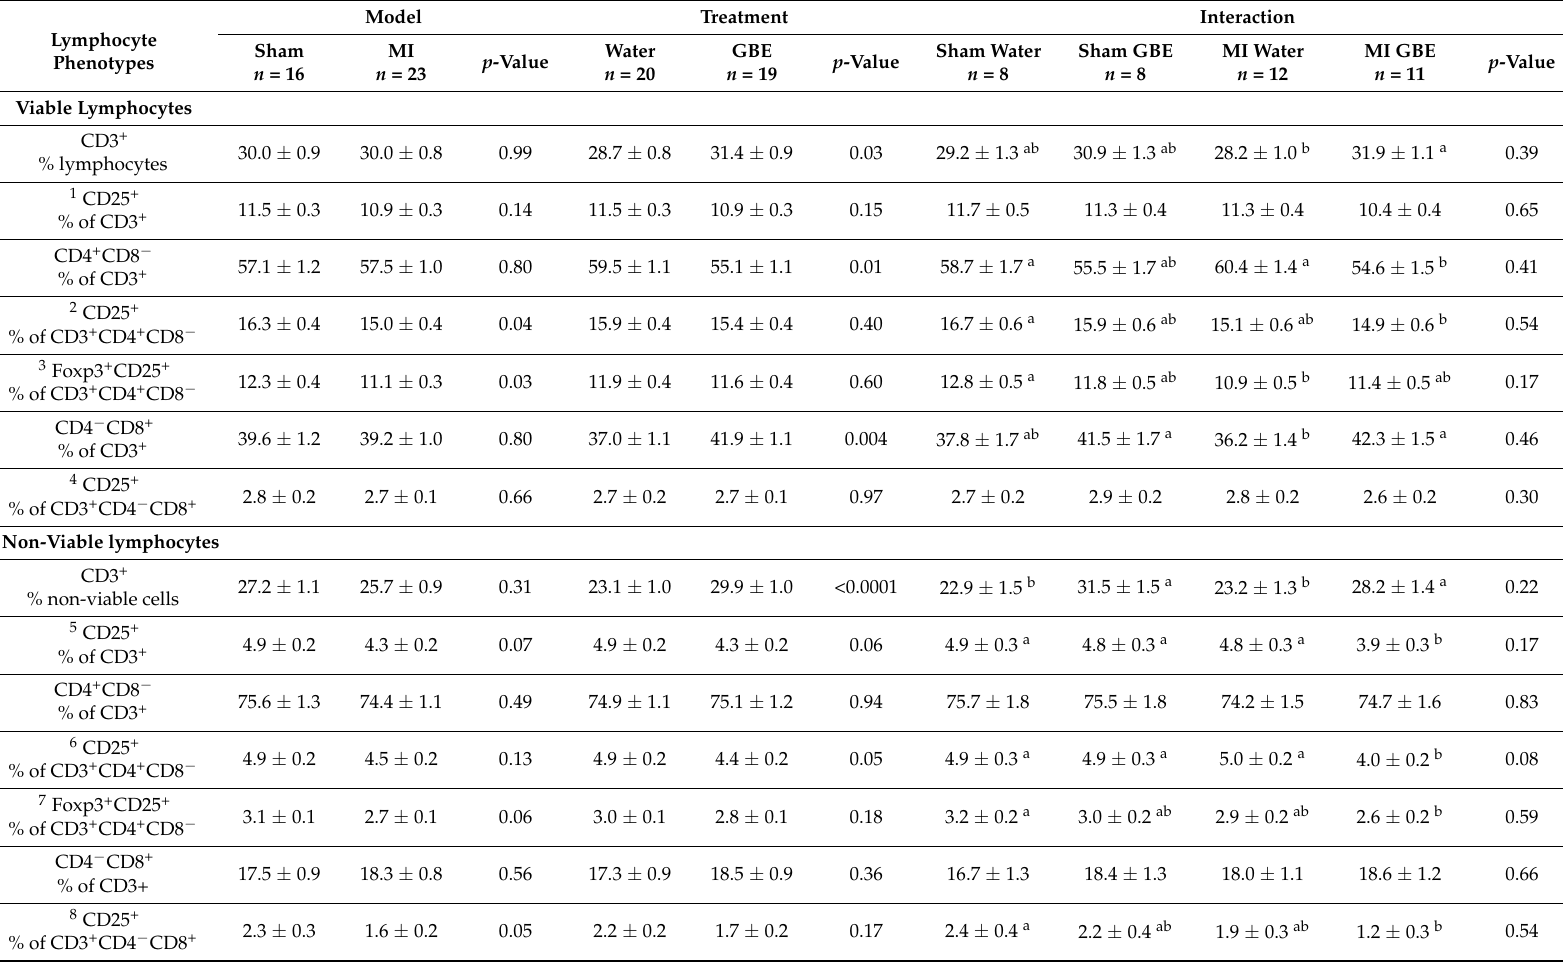
Values are means (pg/mL) ± standard error. Means with different superscript letters are significantly different ( p < 0.05). GBE: Ginseng berry extract. 1,4 : Outliers (value >3 × standard deviation of mean) were removed: 2 from MI water and 1 from sham water group; 2,3,7 : Outliers (value >3 × standard deviation of mean) were removed: 2 from MI water; 5,6,8 : Outlier (value >3 × standard deviation of mean) were removed: 1 from MI